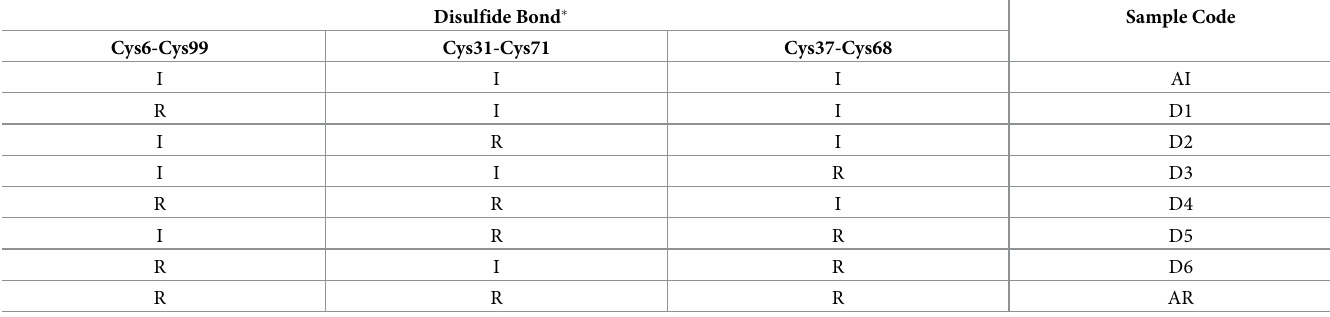
Table 2. Disulfide reduction sample code